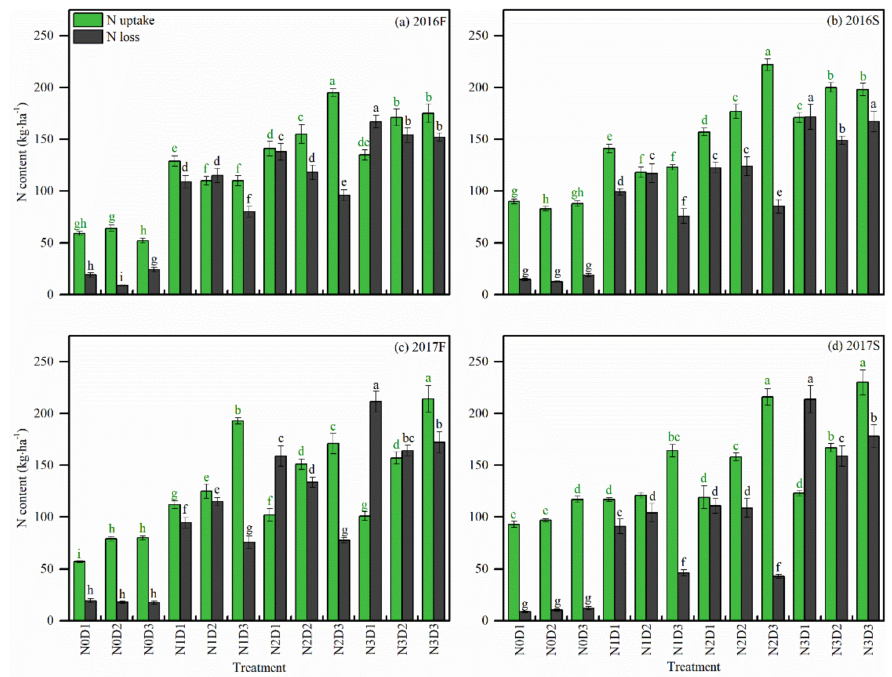
Figure 7. N removal by plants and soil N loss in the perennial rice cropping system. ( a ) N removal and soil N loss in 2016F. ( b ) N removal and soil N loss in 2016S. ( c ) N removal and soil N loss in 2017F. ( d ) N removal and soil N loss in 2017S. Bars with different letters represent significant differences at p < 0.05. The green letter represents the difference in N uptake. The dark letter represents a difference in N